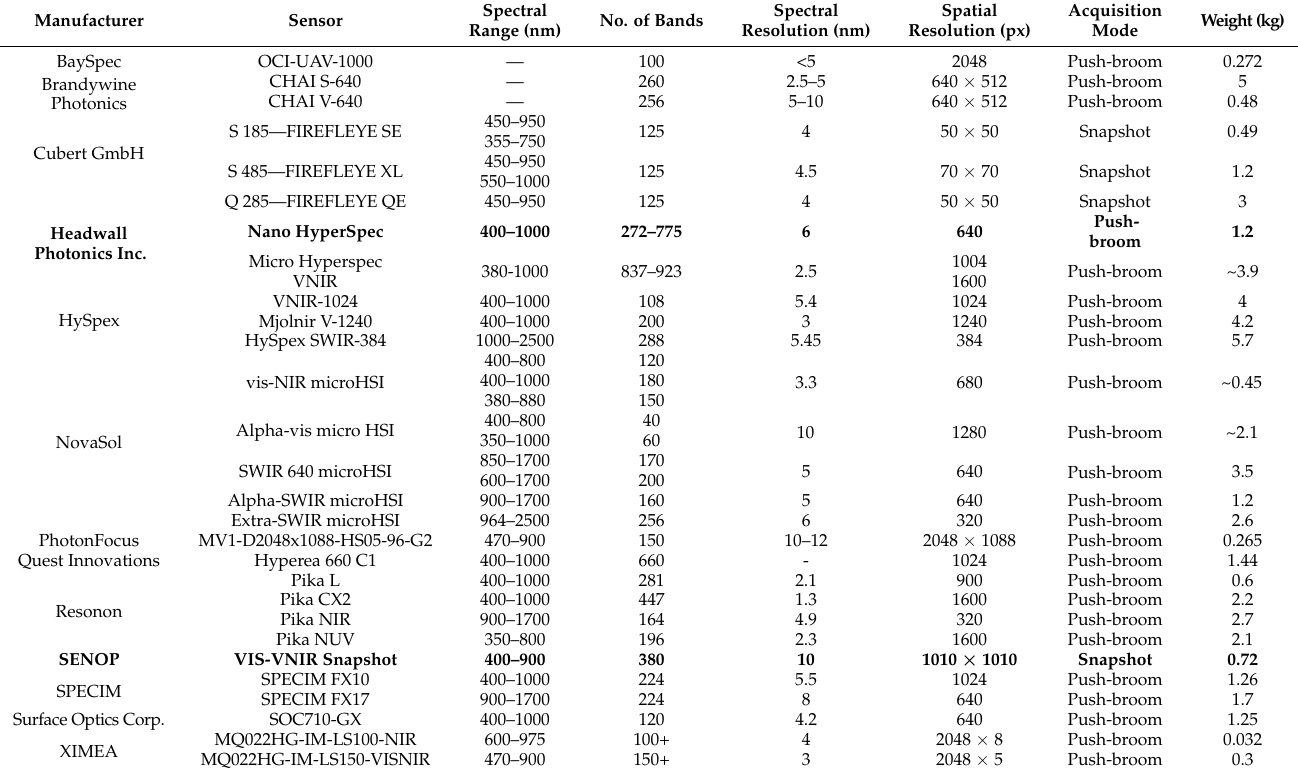
Table 1. Characteristics of the main commercially available hyperspectral sensors developed (or with potential) to be coupled with UAVs (adapted from Ad ã o et al. [24]). The two sensors used in this study are highlighted in